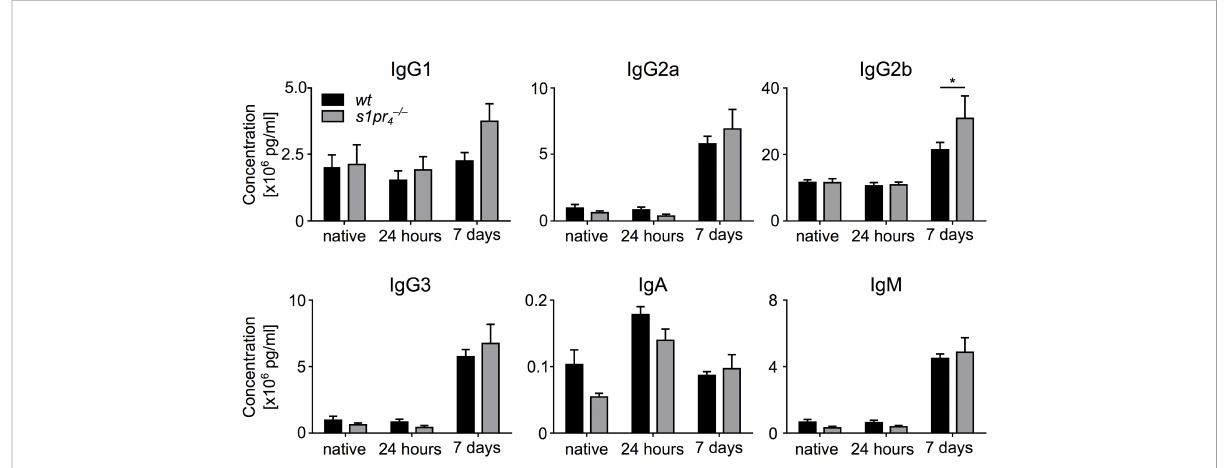
Dynamics of plasma immunoglobulin levels after sepsis induction. Blood plasma of wildtype ( wt ) and S1PR 4 -de fi cient ( s1pr − = − 4 ) mice was analyzed for immunoglobulin levels. Three groups were compared: “ native ” (without sepsis induction), “ 24 hours ” and “ 7 days ” after sepsis induction via CASP. Means + SEM of n = 5 to 8 animals per group. * p <